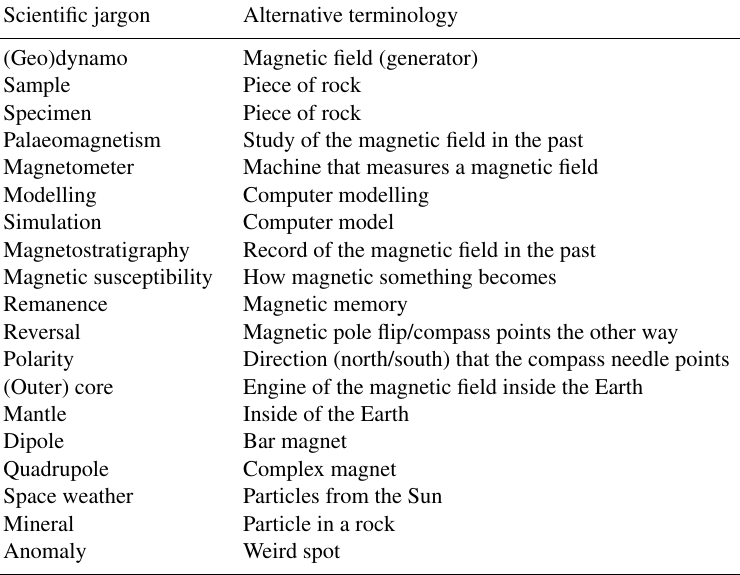
Table 1. Scientific jargon and plain language alternative terminology.